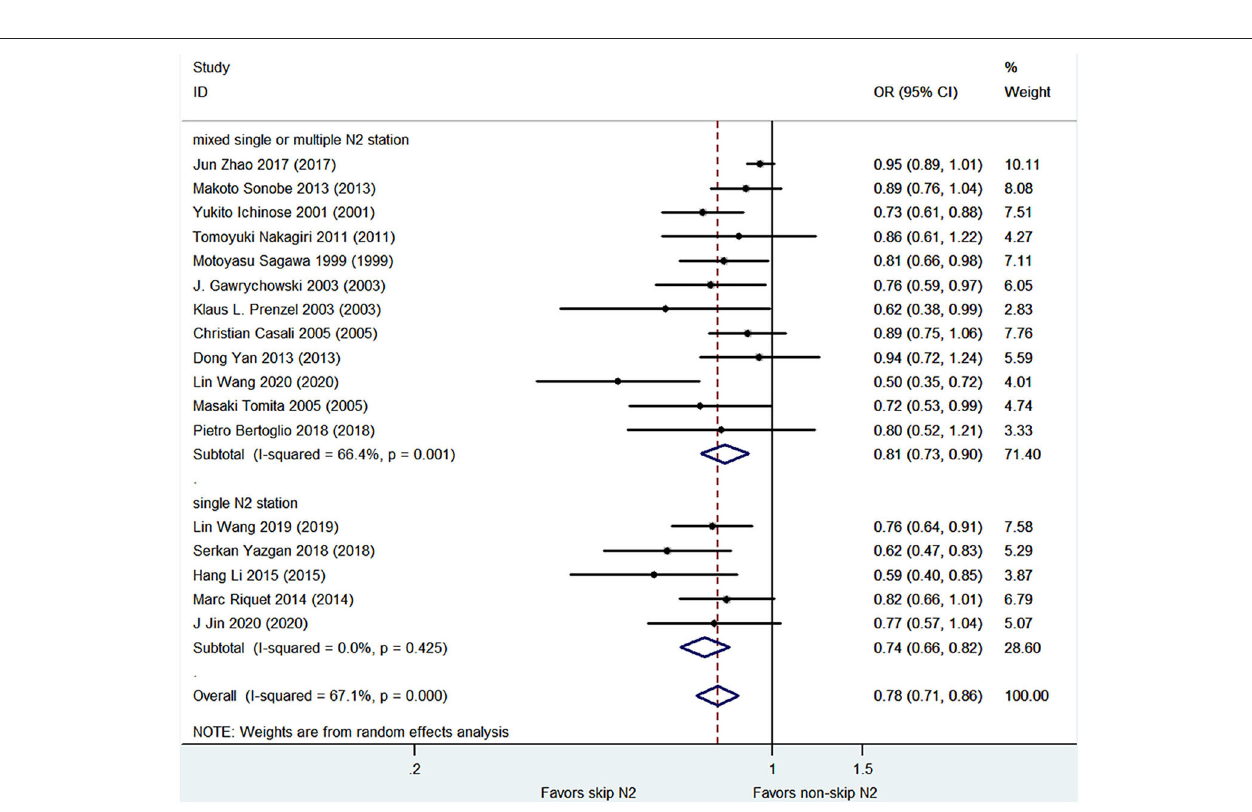
FIGURE 4 | Pooled OR for 5-year survival